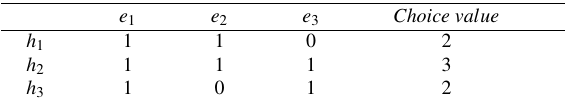
Table 3: Tabular representation of L (( F , A ) , 0 . 6 ) with choice values e 1